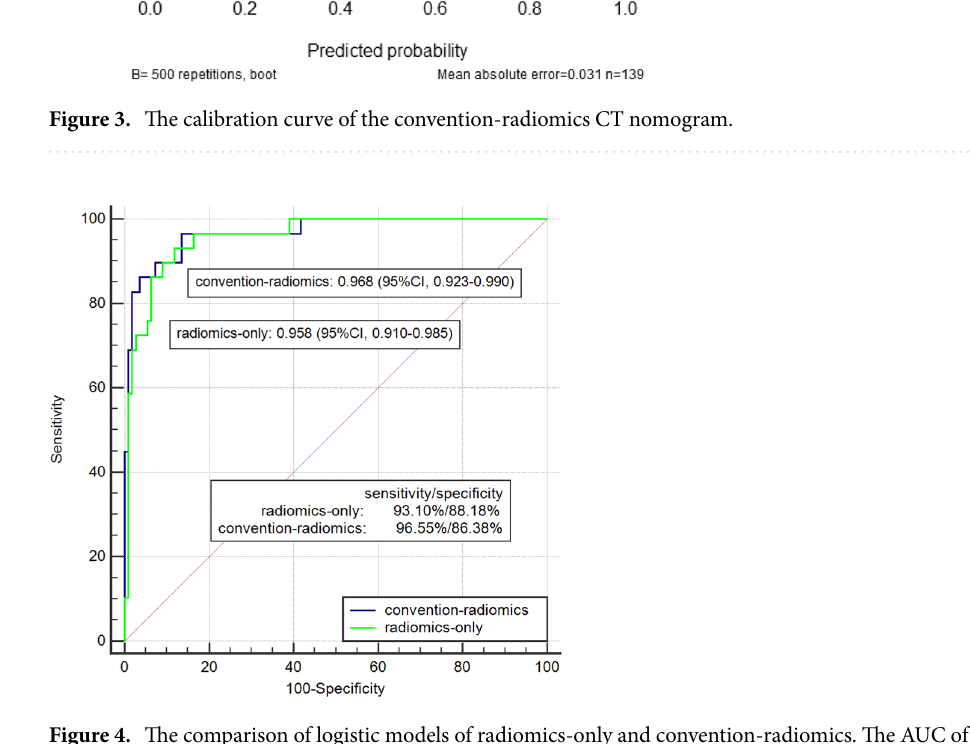
Figure 4. The comparison of logistic models of radiomics-only and convention-radiomics. The AUC of the convention-radiomics logistic model was higher than that of